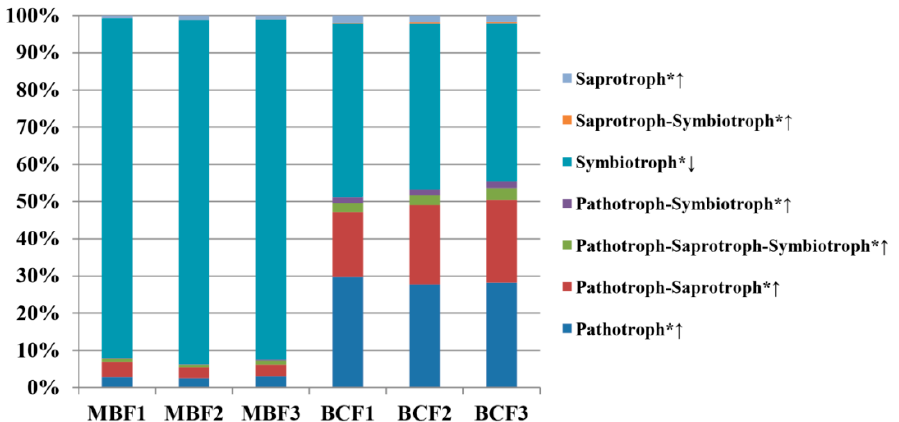
Figure 6. Taxonomy-based functional profiling of fungal communities from the MBF and BCF samples. * ↑ , significantly increased in the BCF samples relative to the MBF samples; * ↓ , significantly decreased in the BCF samples relative to the MBF samples.